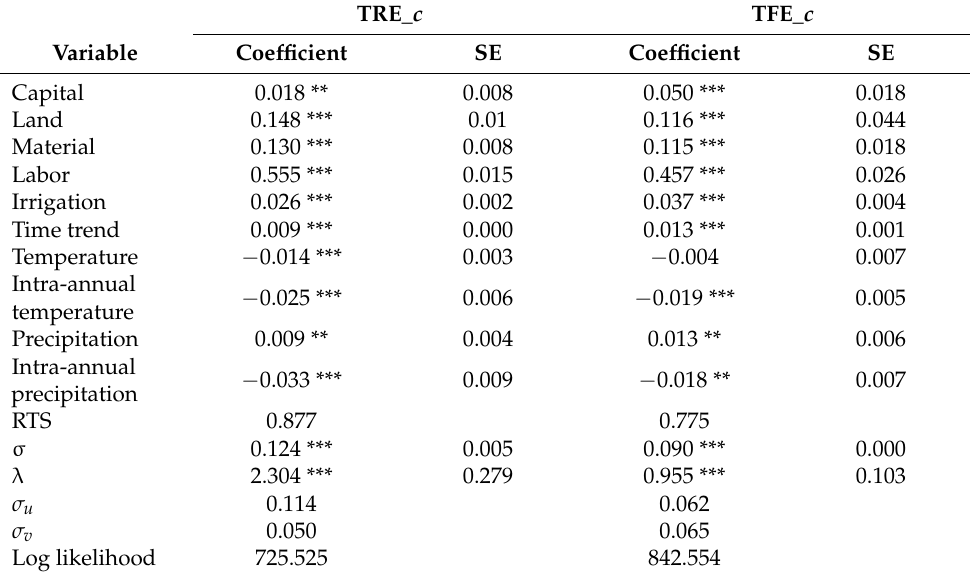
Table 3. Estimates for SPF models with climatic factors (N =